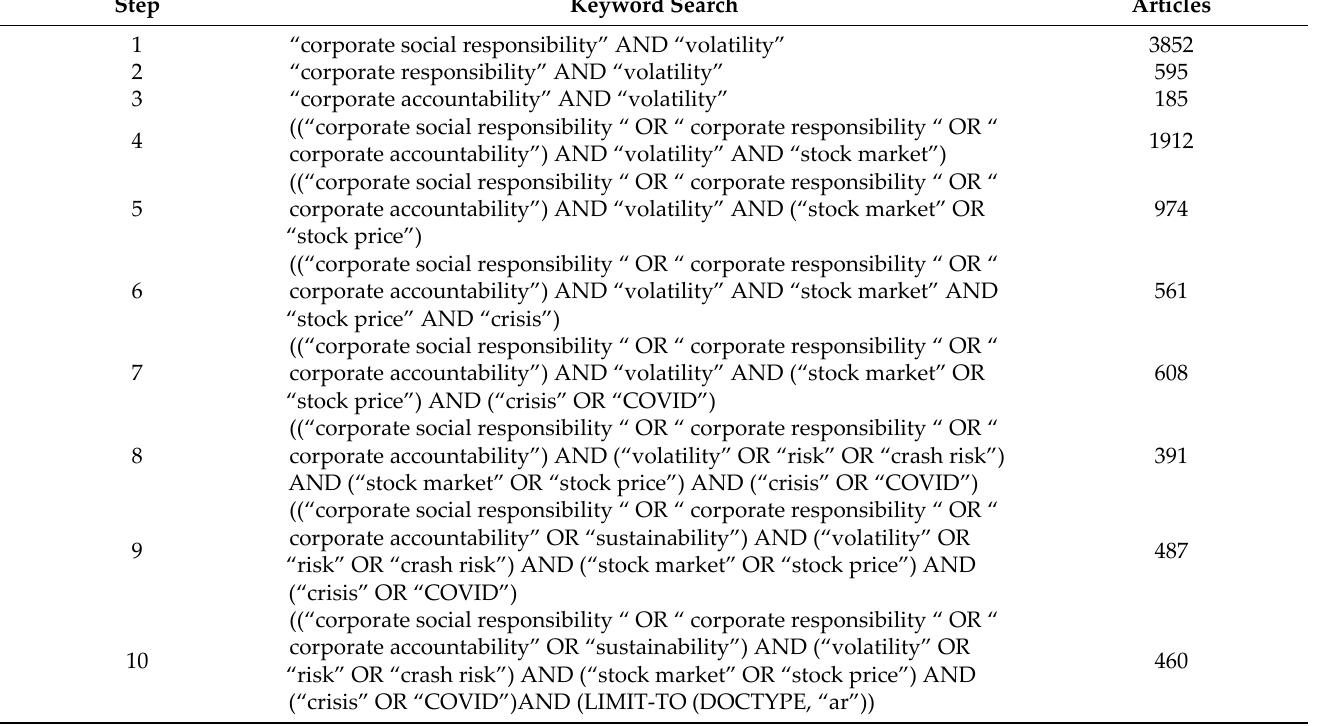
Table 1. Keyword search process in Scopus database. Source: Scopus/Biblioshiny (Own